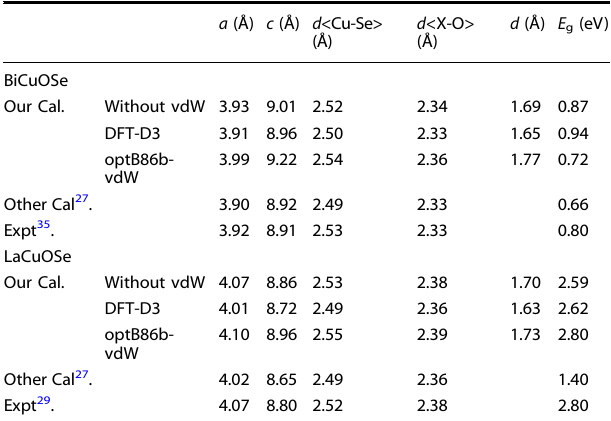
Table 2. The calculated DP constant E 1 , elastic constant C ii and effective mass m * for BiCuOSe and LaCuOSe. Carrier